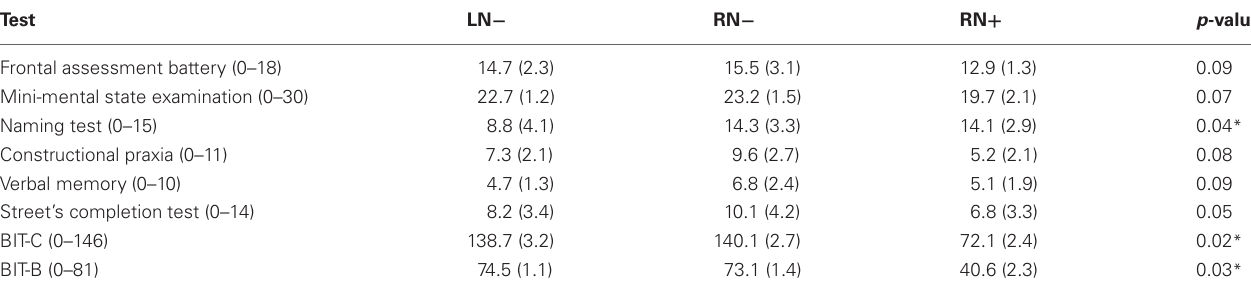
Table 2 | Results obtained at the neuropsychological assessment by the LN − , RN − , and RN + patients.